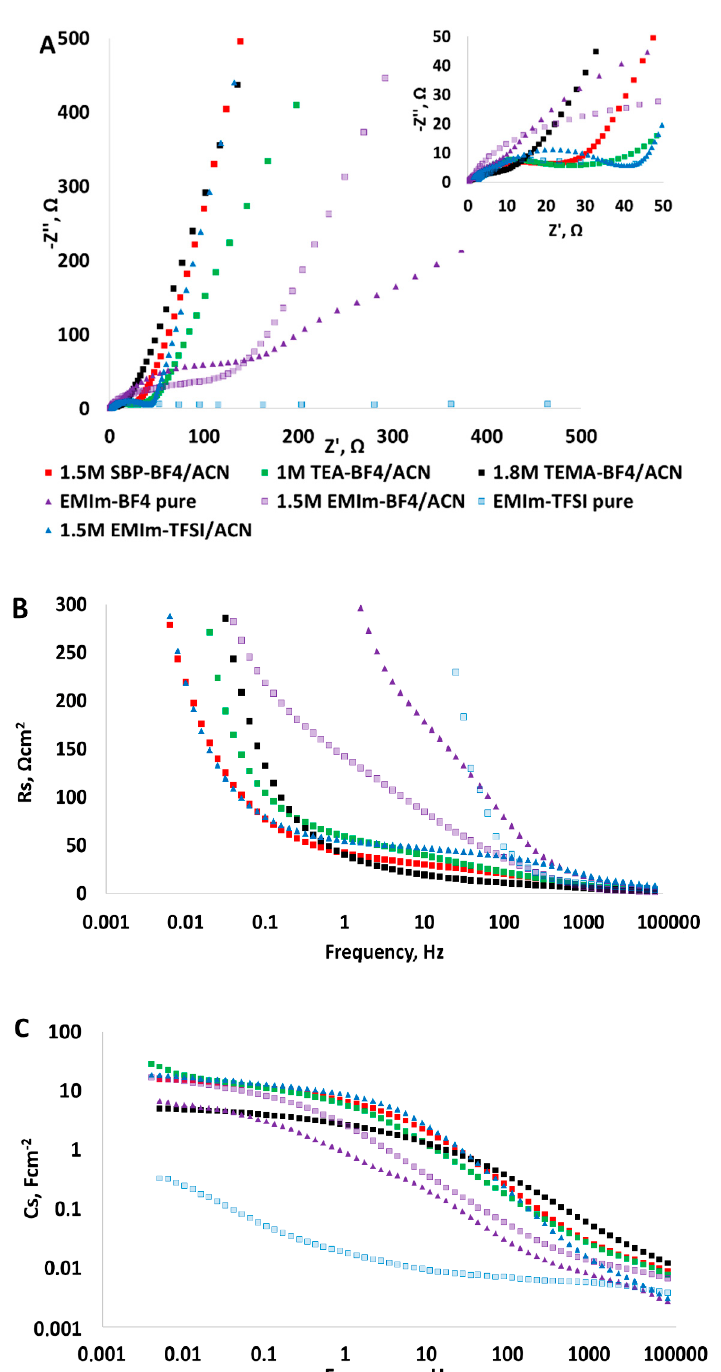
Figure 8. Electrochemical impedance spectroscopy (EIS) plots for electrolyte-carbon interface: ( A ) Nyquist plot, ( B ) R s as a function frequency and ( C ) C s as a function of frequency.